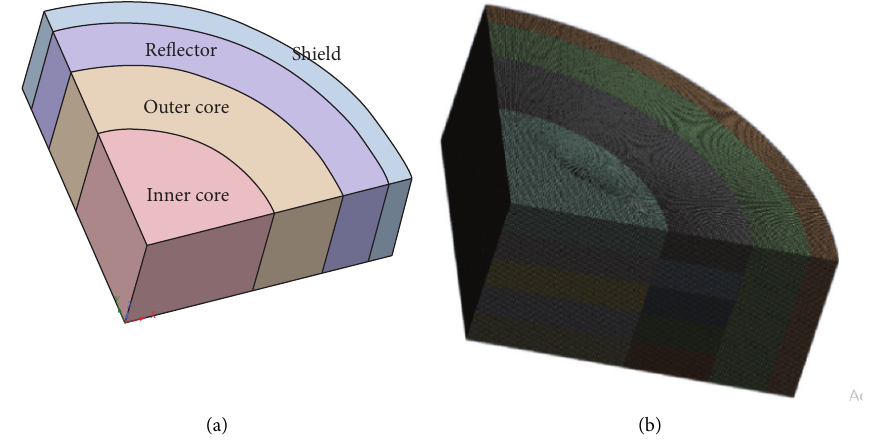
Figure 8: (a) Regional model and (b) mesh of MET-1000. Table 3: Comparison of the single PWR cell model results. K eff Peak clad temperature Results in reference [7]